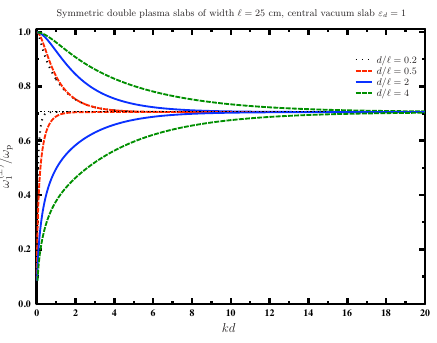
Figure 2: Dispersion curves of two identical plasma slabs with vacuum as a central region.